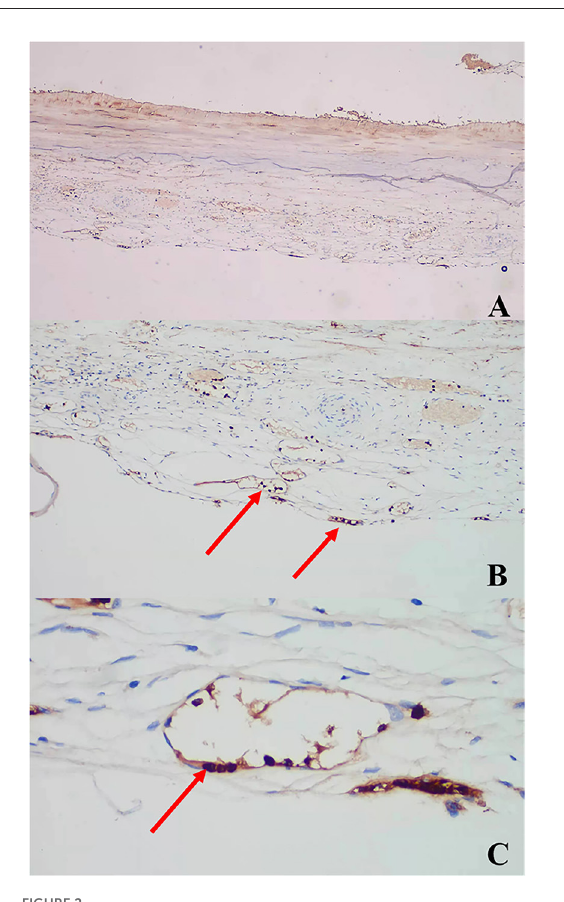
FIGURE2 Anti-MMP-9 antibody immunostaining: (A) × 40, (B) × 100, (C) × 400